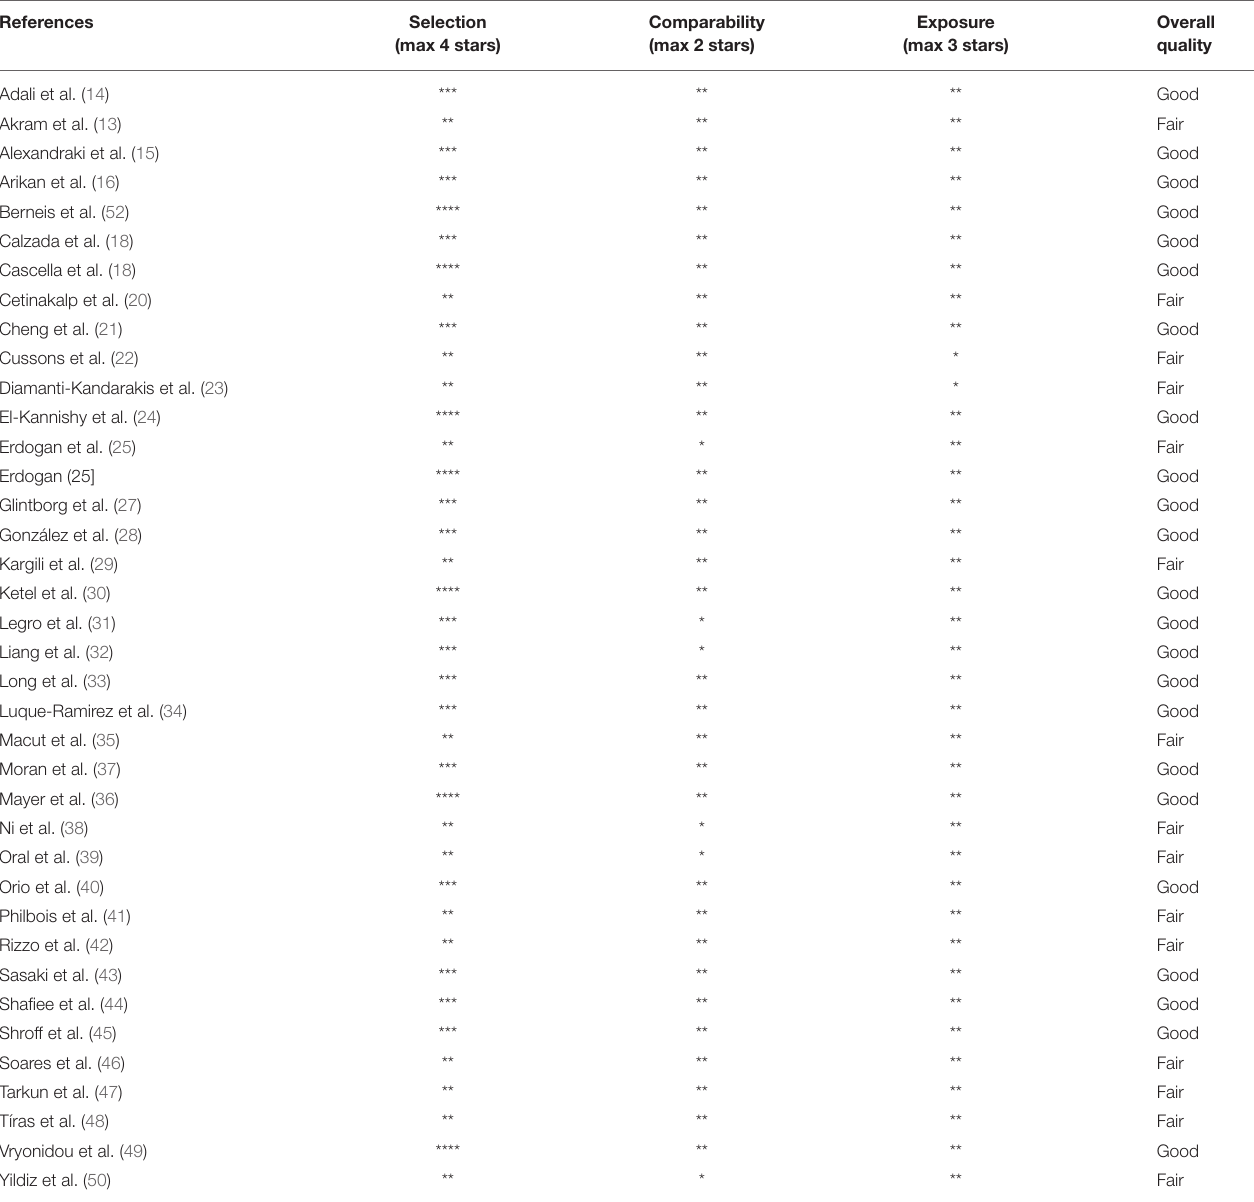
TABLE 3 | Assessment of methodological quality (based on Newcastle-Ottawa Scale).